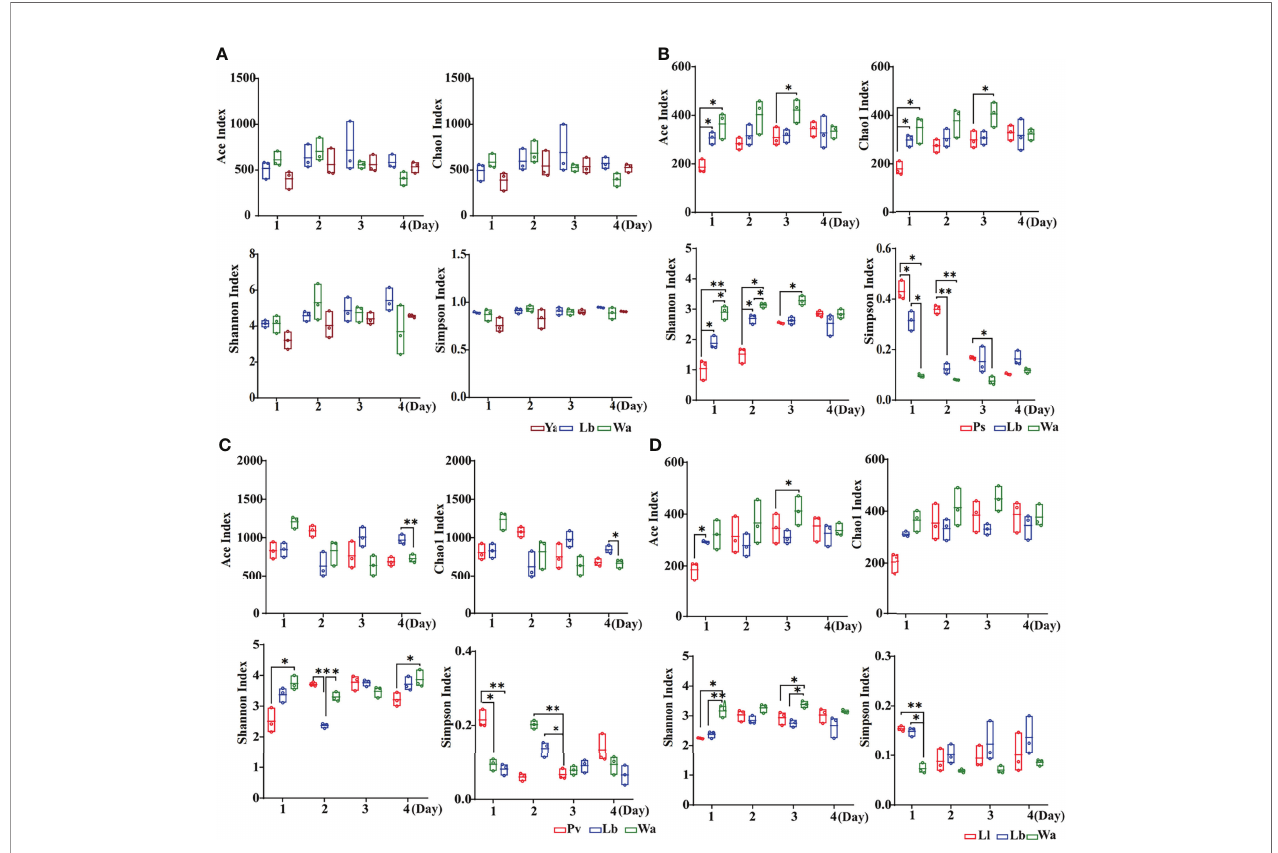
FIGURE 3 | Effects of “ harmful bacteria ” (A – C) and “ neutral bacteria ” (D) in the guts of house fl y larvae on the intestinal diversity index of larvae. Ya, Pseudomonas aeruginosa ; Ps, Providencia stuartii ; Pv, Providencia vermicola ; Ll, Lactococcus lactis . Wa, sterile water, blank control group; Lb: Luria-Bertani liquid medium, negative control group; Day 1, Day 2, Day 3, Day 4: the developmental period of house fl y larvae. *p < 0.05, **p < 0.01, ***p <